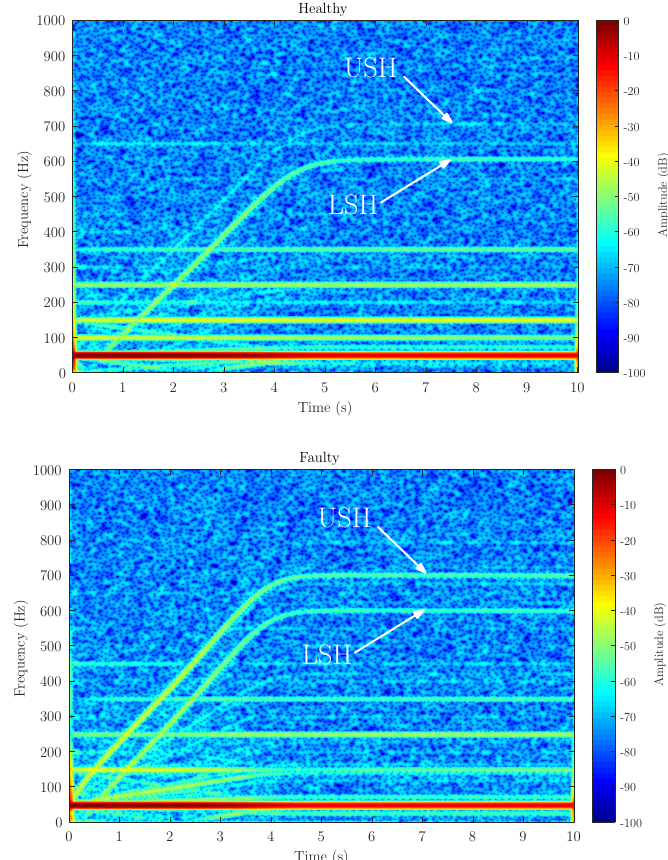
Figure 13. Stator current spectrogram of the experimental machine, in healthy ( top ) and in faulty ( bottom ) conditions. It can be seen the characteristic trajectory in the time–frequency plane of the USH, generated in the case of a start-up transient of 5 s, as well as the evolution of the USH amplitude, which increases as the degree of the severity fault